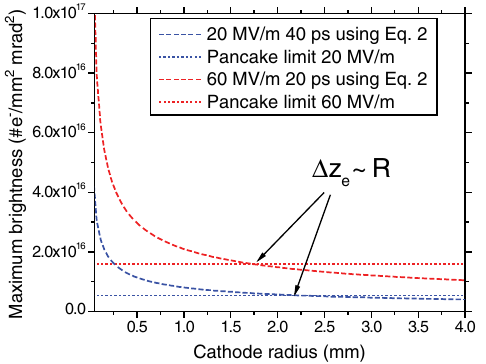
FIG. 6 (color online). Maximum brightness as a function of beam radius. We have assumed a typical value for the normalized rms transverse momentum spread